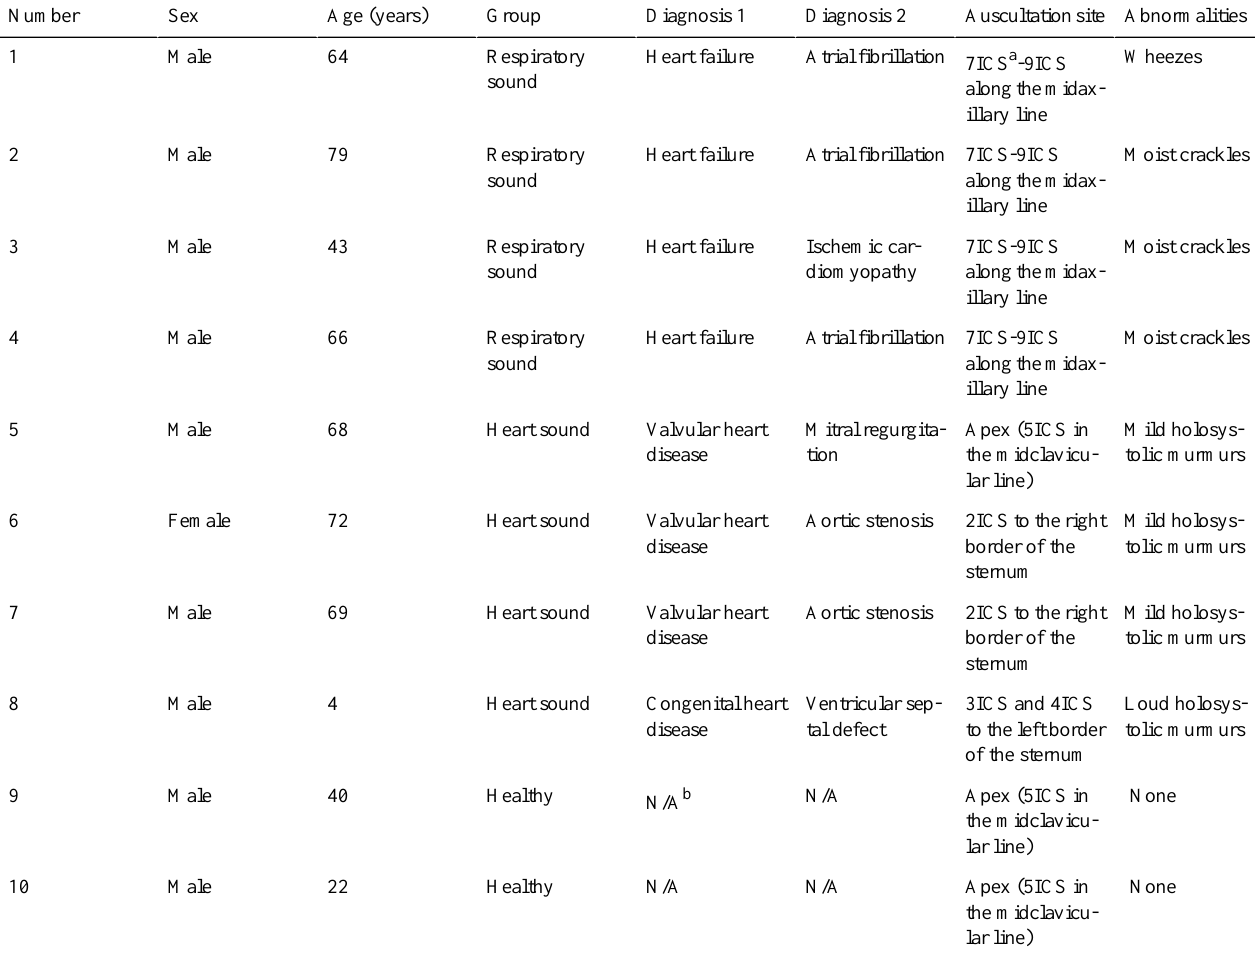
Table 3. Demographic characteristics of the patients and volunteers in the pilot